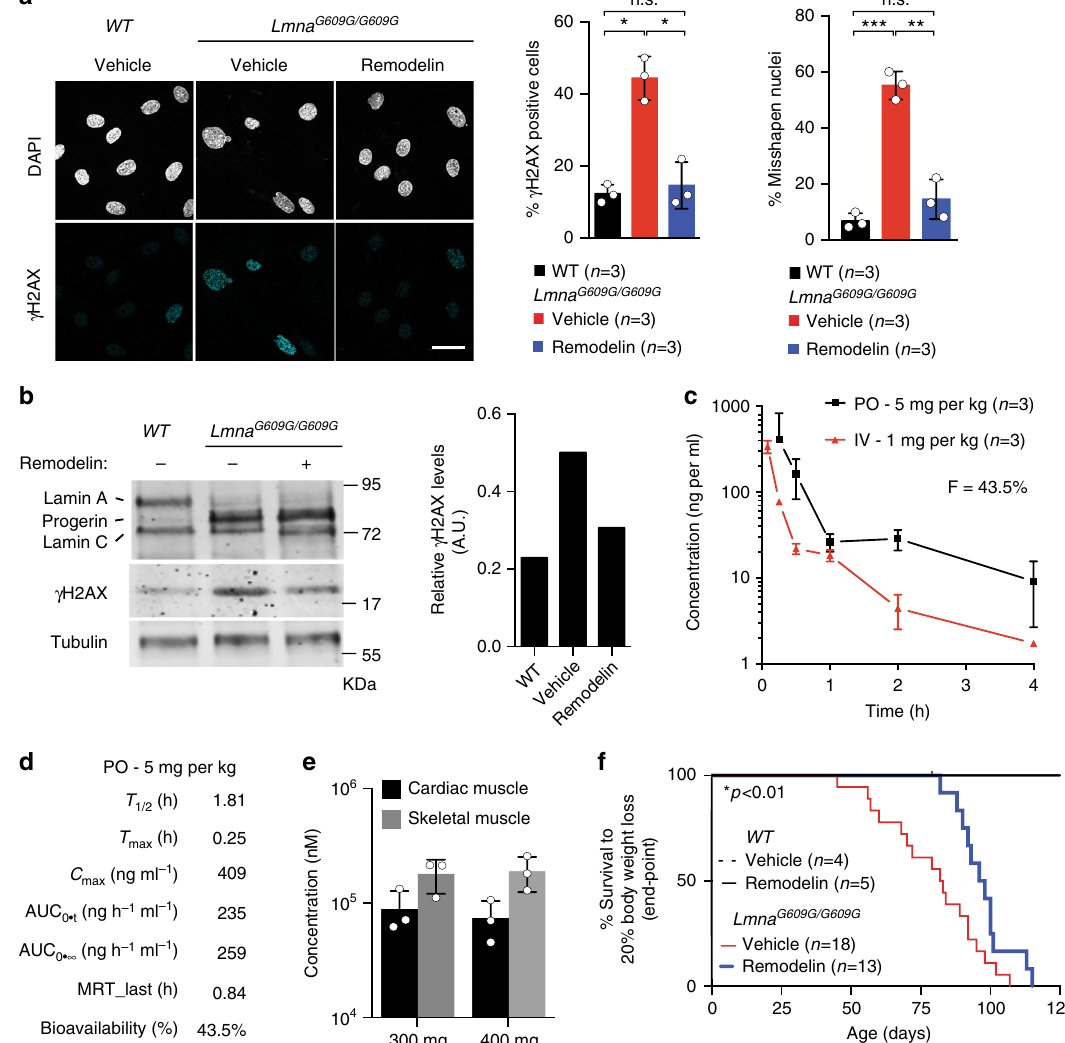
Fig. 1 Oral administration of Remodelin decreases weight loss in progeria mice. a , b Cells were treated with DMSO or with 1 µ M Remodelin for 7 days. a Left: Representative immuno fl uorescence images of skin fi broblasts from Lmna G609G/G609G mice showing the accumulation of the DNA double-strand break marker gamma H2AX ( γ H2AX) ( blue) and characteristic nuclear shape abnormalities, observed by DAPI staining. All images were acquired with the same microscope intensity settings. Scale bar 20 µ m. Right: Quanti fi cation of γ H2AX positive cells and cells with misshapen nuclei (>100 cells/ n = 3 independent cell lines; mean ± s.d.; n.s. not signi fi cant; * p < 0.05, ** p < 0.01, *** p < 0.001, two-tailed Student ’ s t -test). b Western blotting analysis of γ H2AX levels (quanti fi ed in the right panel) in skin fi broblasts from the indicated genotypes. c,d Pharmacokinetic analyses of Remodelin in mice treated via oral (PO; n = 3) or intravenous (IV; n = 3) delivery; mean ± s.e.m. F absolute bioavailability (%). e Tissues were collected after 2 weeks of daily PO administration of the indicated Remodelin concentration and 1 h after the last dosing. Remodelin was quanti fi ed by mass spectrometry in the heart and the skeletal muscle ( n = 3); mean ± s.e.m. f Survival based on 20% body weight loss, showing a 25% increase in Kaplan – Meier area under the curve in Remodelin-treated Lmna G609G/G609G mice, as compared to vehicle-treated mice (see Supplementary Table 3); (*Log-rank Mantel-Cox test; Chi-square 5.992). Due to animal welfare regulations, mice had to be killed when they had lost 20% of their body weight, compared to their individual weight